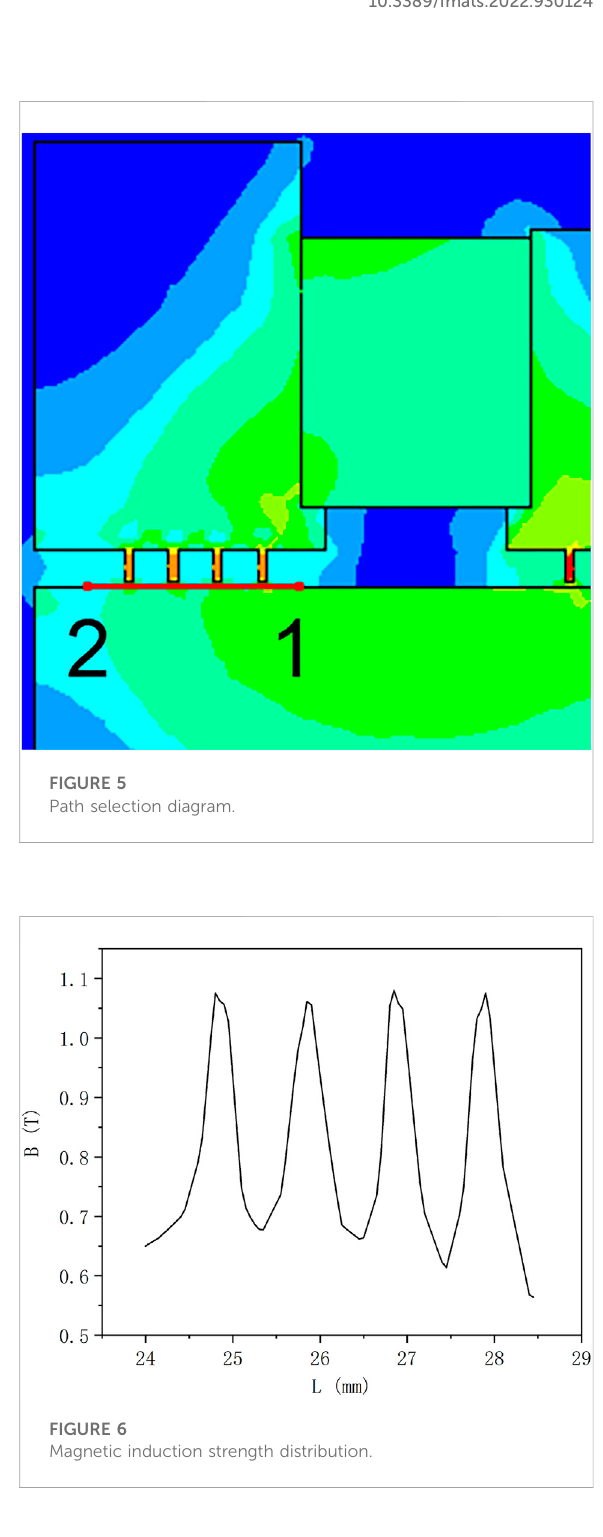
FIGURE 6 Magnetic induction strength